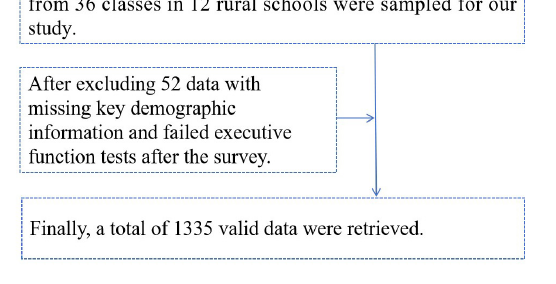
FIGURE1 Flow chart of the sampling of participants in this